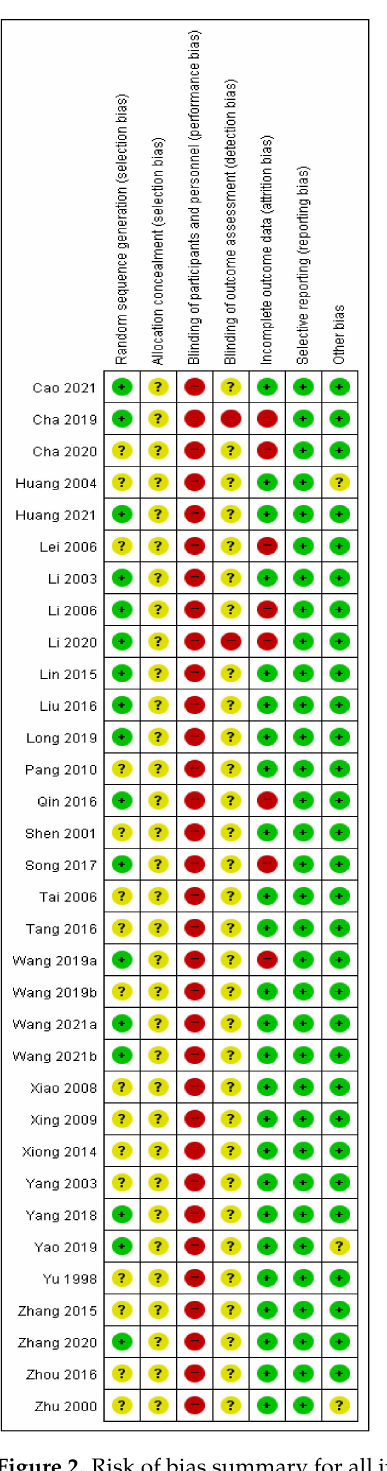
Figure 2. Risk of bias summary for all included studies. Low, unclear, and high risk of bias, respec- tively, are represented with the following symbols: “+”, “?”, and “ − ”